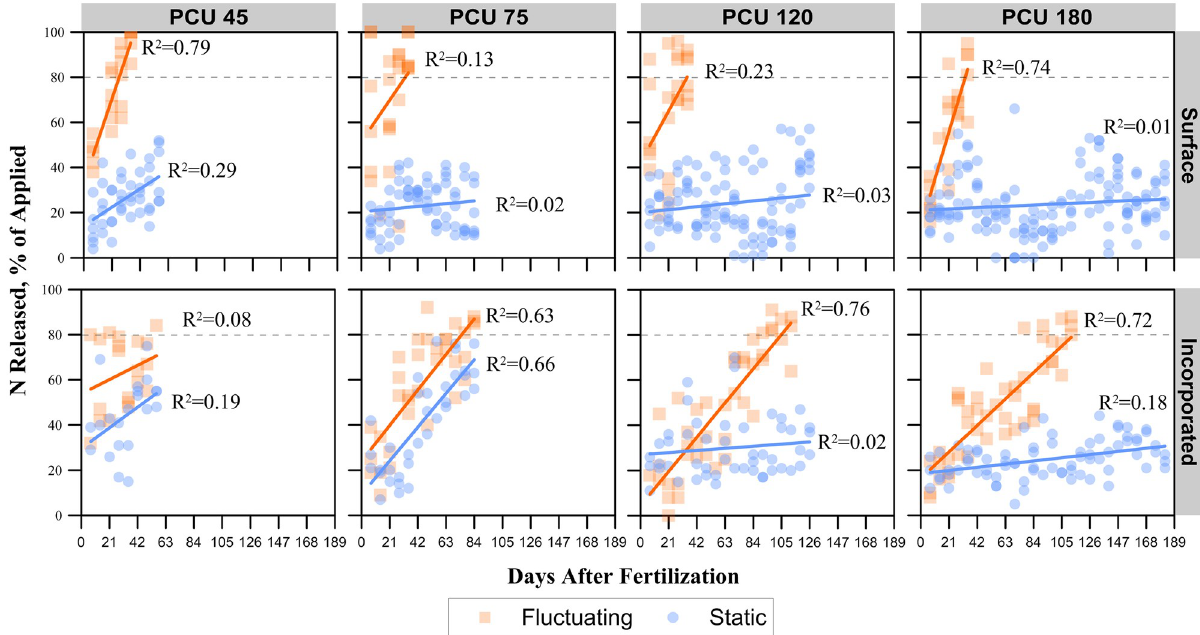
Fig 3. Experiment 1 N release rates for various fertilizer sources. (PCU) polymer-coated urea products with varying targeted release timings of 45, 75, 120, and 180 days applied either to the soil/thatch layer surface or incorporated into the soil at either static or fluctuating daily temperatures. The dashed vertical line indicates the targeted cumulative release